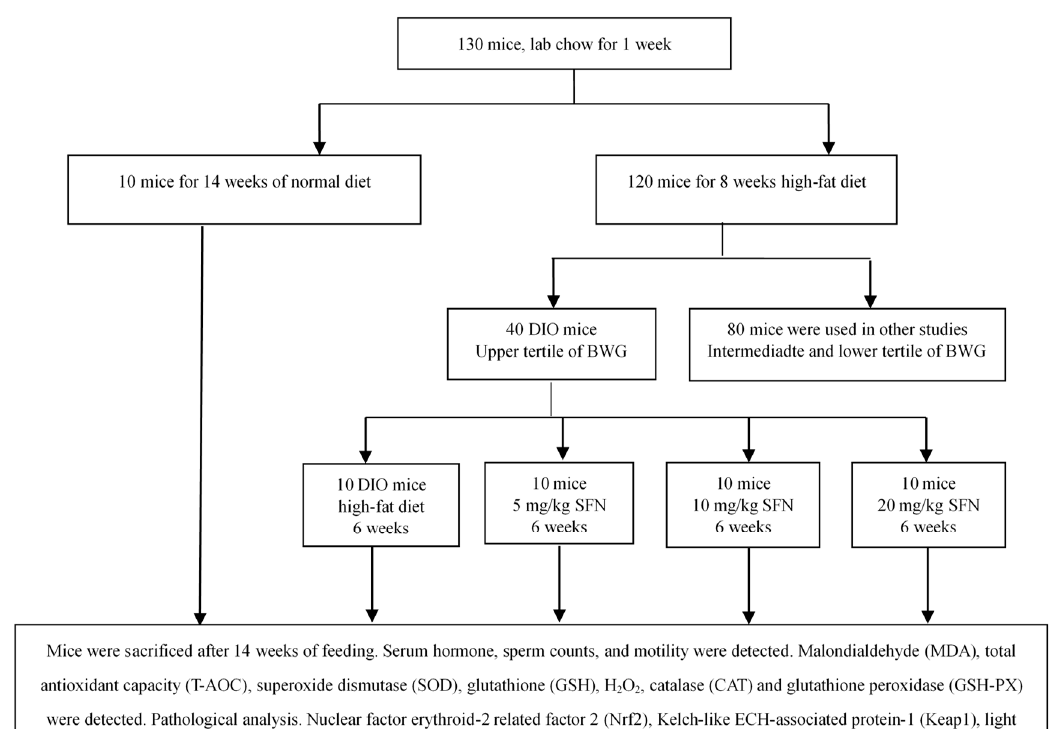
Figure 2. The flow diagram of experimental progress.